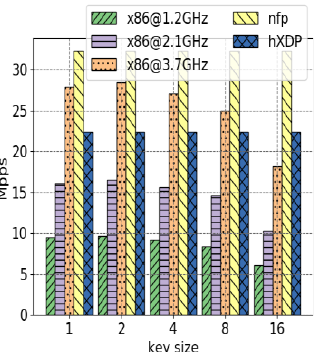
Figure 13. Impact on forwarding output on map accesses.